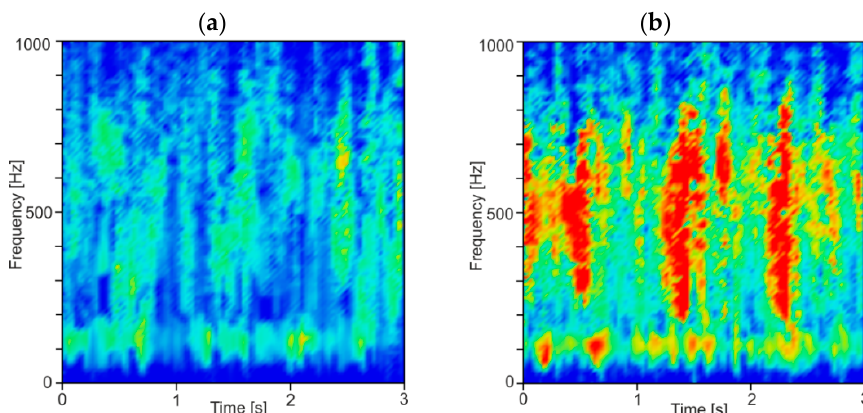
Figure 8. Time–frequency spectrogram for: ( a ) stable ( a p = 0.5 mm, n = 6000 rpm) and ( b ) unstable cutting ( a p = 0.5 mm, n = 7000 rpm).